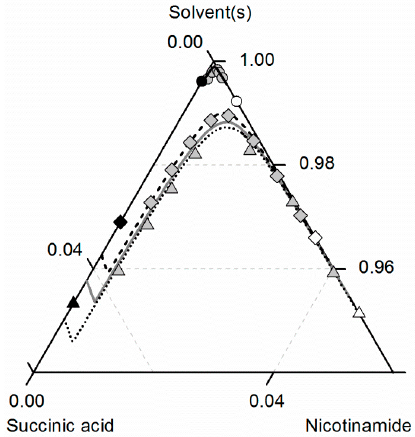
Figure 9. Solubilities of nicotinamide (NA) and succinic acid (SA) and the corresponding 2:1 cocrystal (CC) in ethanol (gray solid lines), ethyl acetate (circles, black solid lines) and ethanol-ethyl acetate mixtures 0.5/0.5 w/w (triangles, black dotted lines) and 0.25/0.75 w / w (diamonds, black dashed lines) at 298.15 K with shortened axes in mole fractions. Lines correspond to the PC-SAFT predictions; symbols refer to the experimental data points of SA (black), the CC (gray) and NA (white).